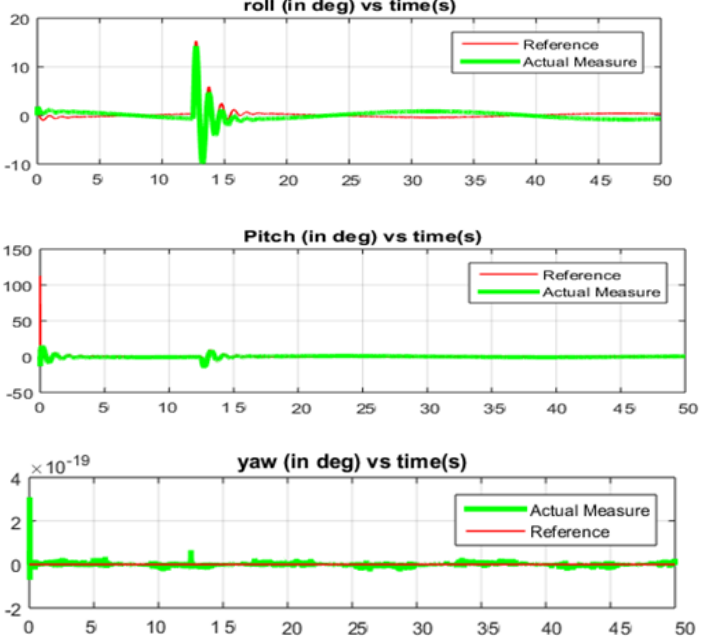
Figure 16. Roll, pitch and yaw responses using SDF-SMC control technique.